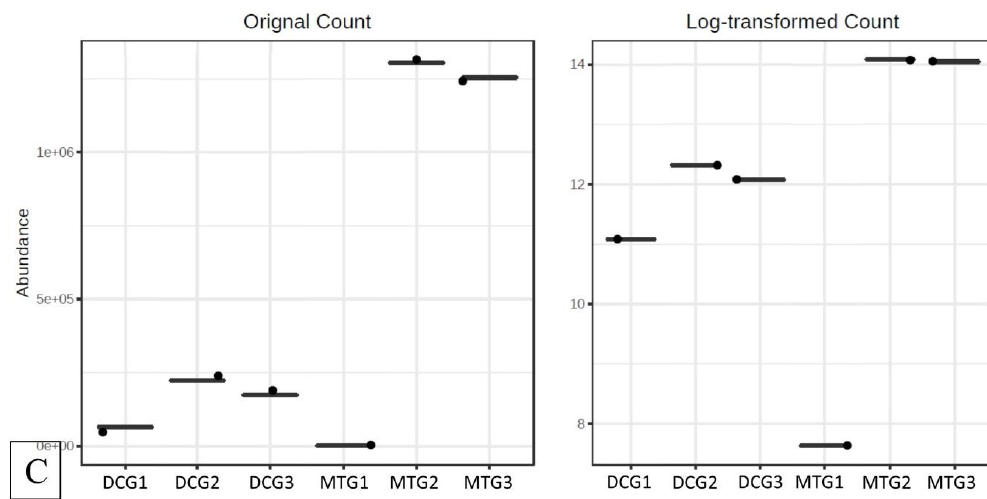
Figure 4. Differential abundance statistical analysis for ( A ) Burkholderia , ( B ) Bradyrhizobium , and ( C ) Rhodanobacter species in the DC/MT generations.